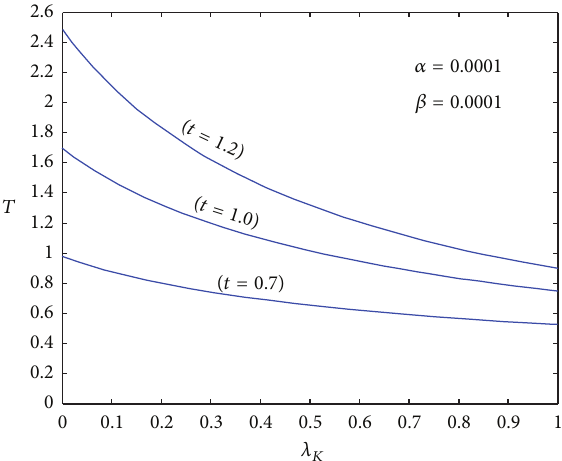
Figure 4: The change curve of the macroscopic inner friction coefficient with aggregate stiffness ratio for different matrix inner friction